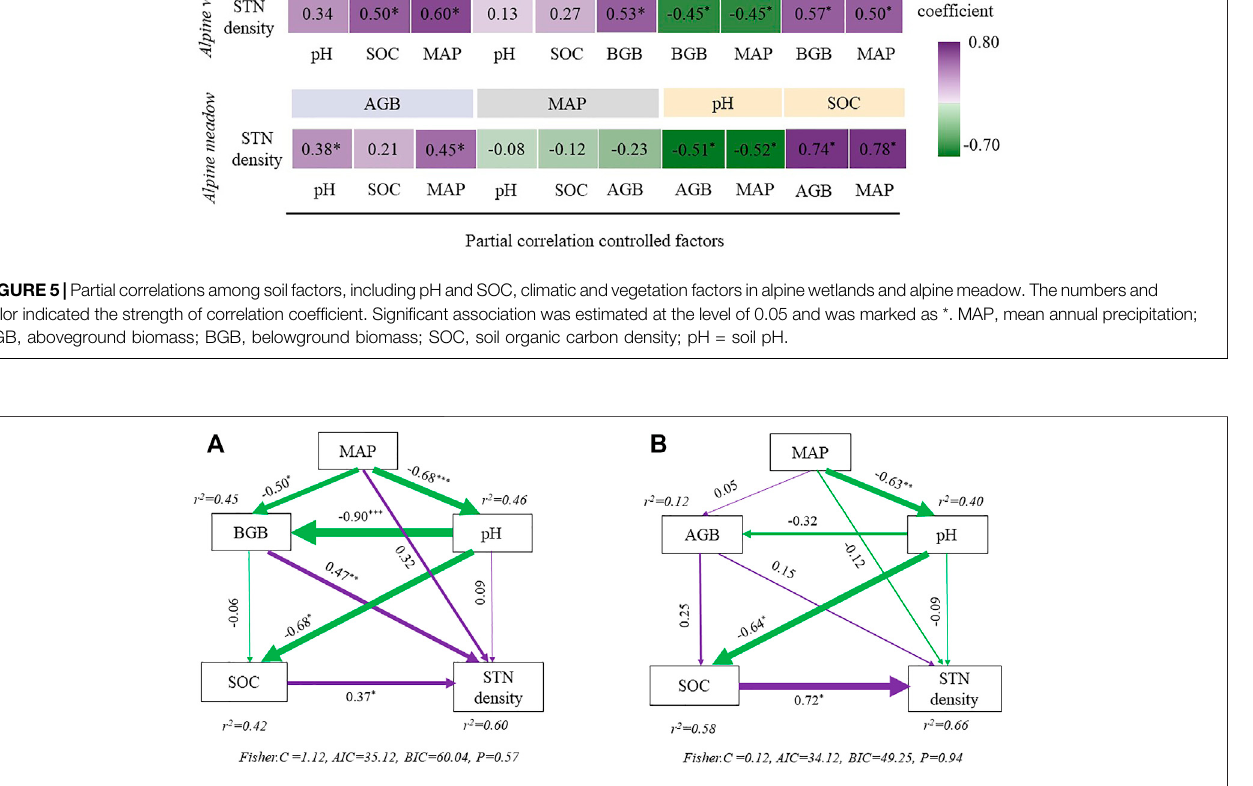
FIGURE 6 | Structural equation models for depicting direct and indirect drivers to soil total nitrogen density in alpine wetlands (A) and alpine meadow (B) . The numbers at the arrows indicate standardized path coef fi cients and arrow width indicates proportion of the relative strength for the relationship. The asterisks beside the numbers were used to indicate the signi fi cance of each path coef fi cient (* p < 0.05, ** p < 0.01, *** p < 0.001). The colors purple and green inferred to positive effects and negative effects. STN density, soil total nitrogen density; MAP, mean annual precipitation; BGB, belowground biomass, AGB, aboveground biomass; pH, soil pH; SOC, soil organic carbon